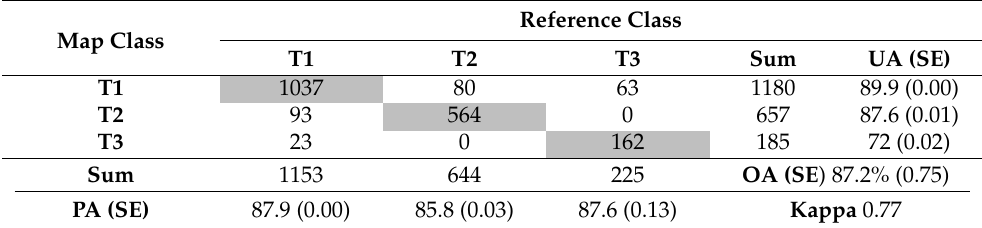
Table 4. Confusion matrix of RF result for the EUNIS II level classification. T1: broadleaved deciduous forest habitat-type, T2: broadleaved evergreen forest habitat-type, T3: needleleaved forest habitat-type. OA: Overall Accuracy, PA: Producer’s Accuracy, UA: User’s Accuracy, SE: Standard Error.